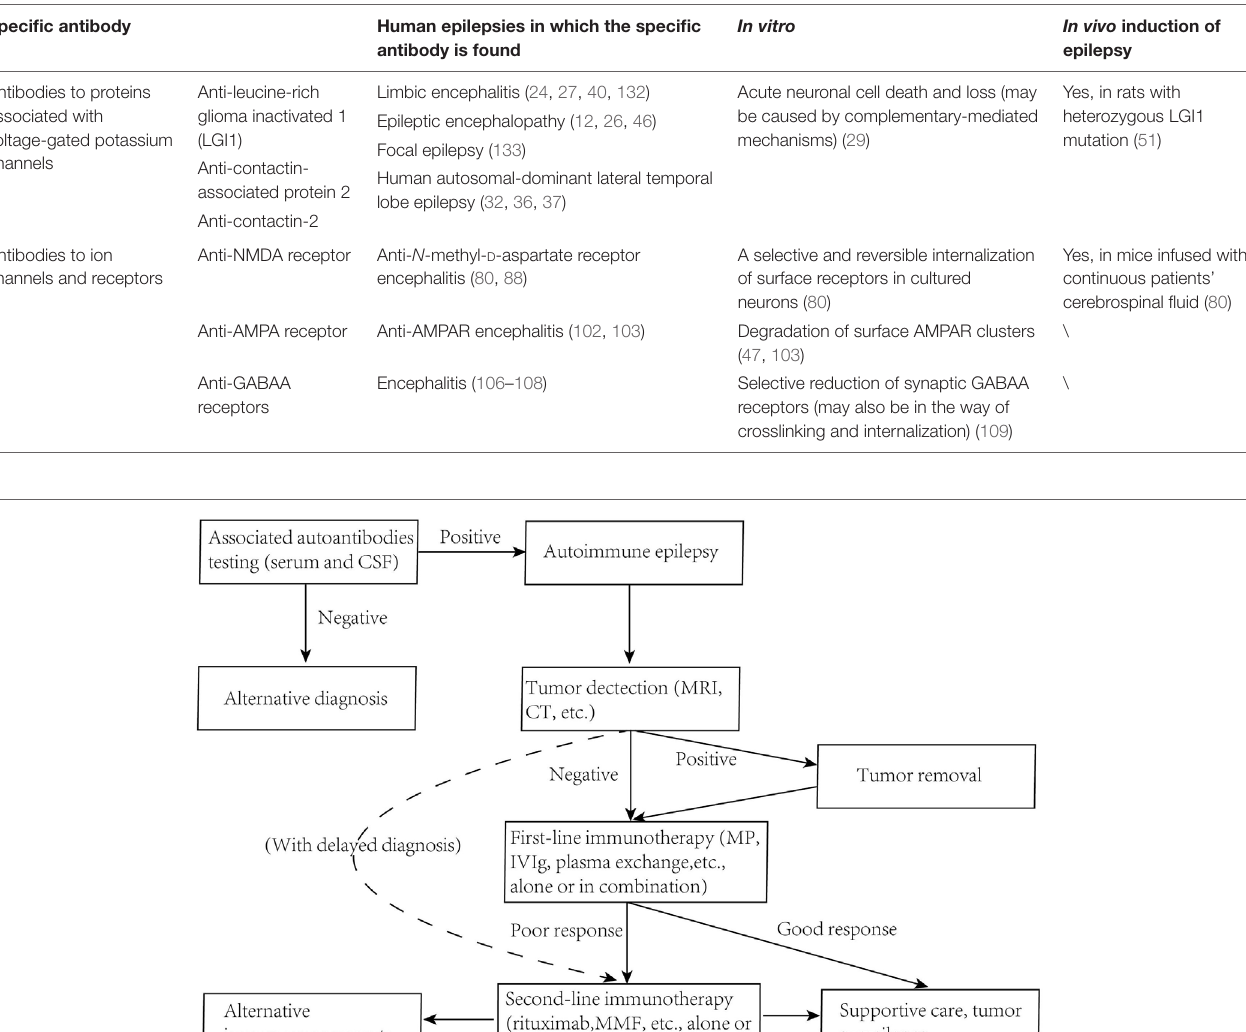
TABLe 2 | Autoantibodies in human epilepsy and animal models.